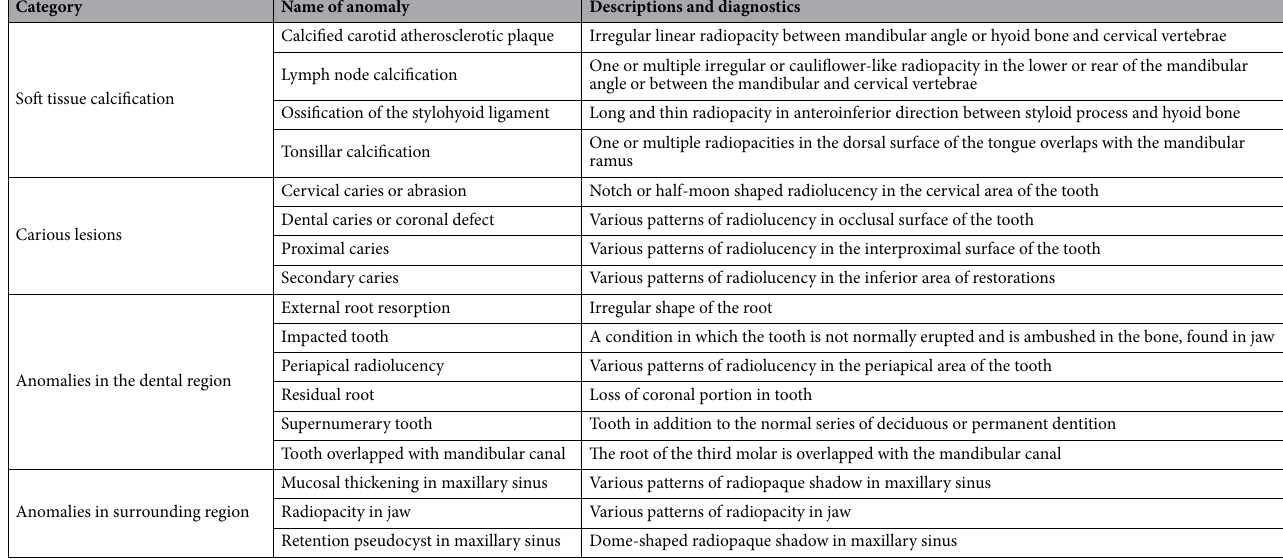
Table 1. Category, name, and labeling criteria of 17 fine-grained dental